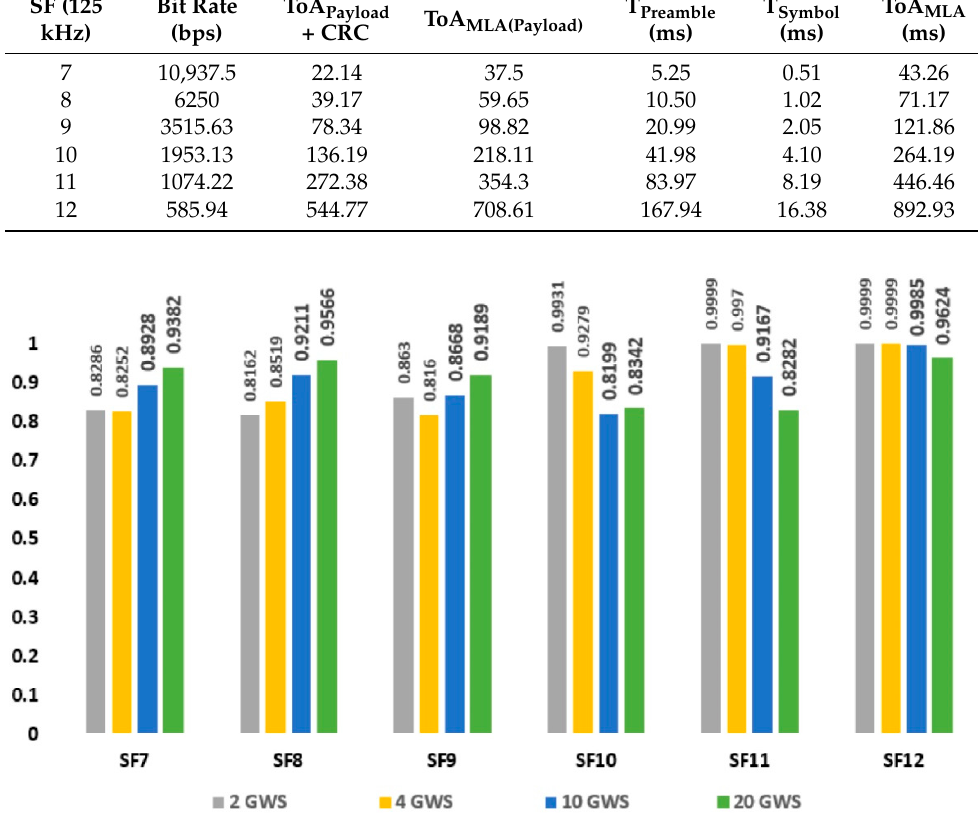
Figure 8. Multi-gateways using K-means MLA (250 kHz).